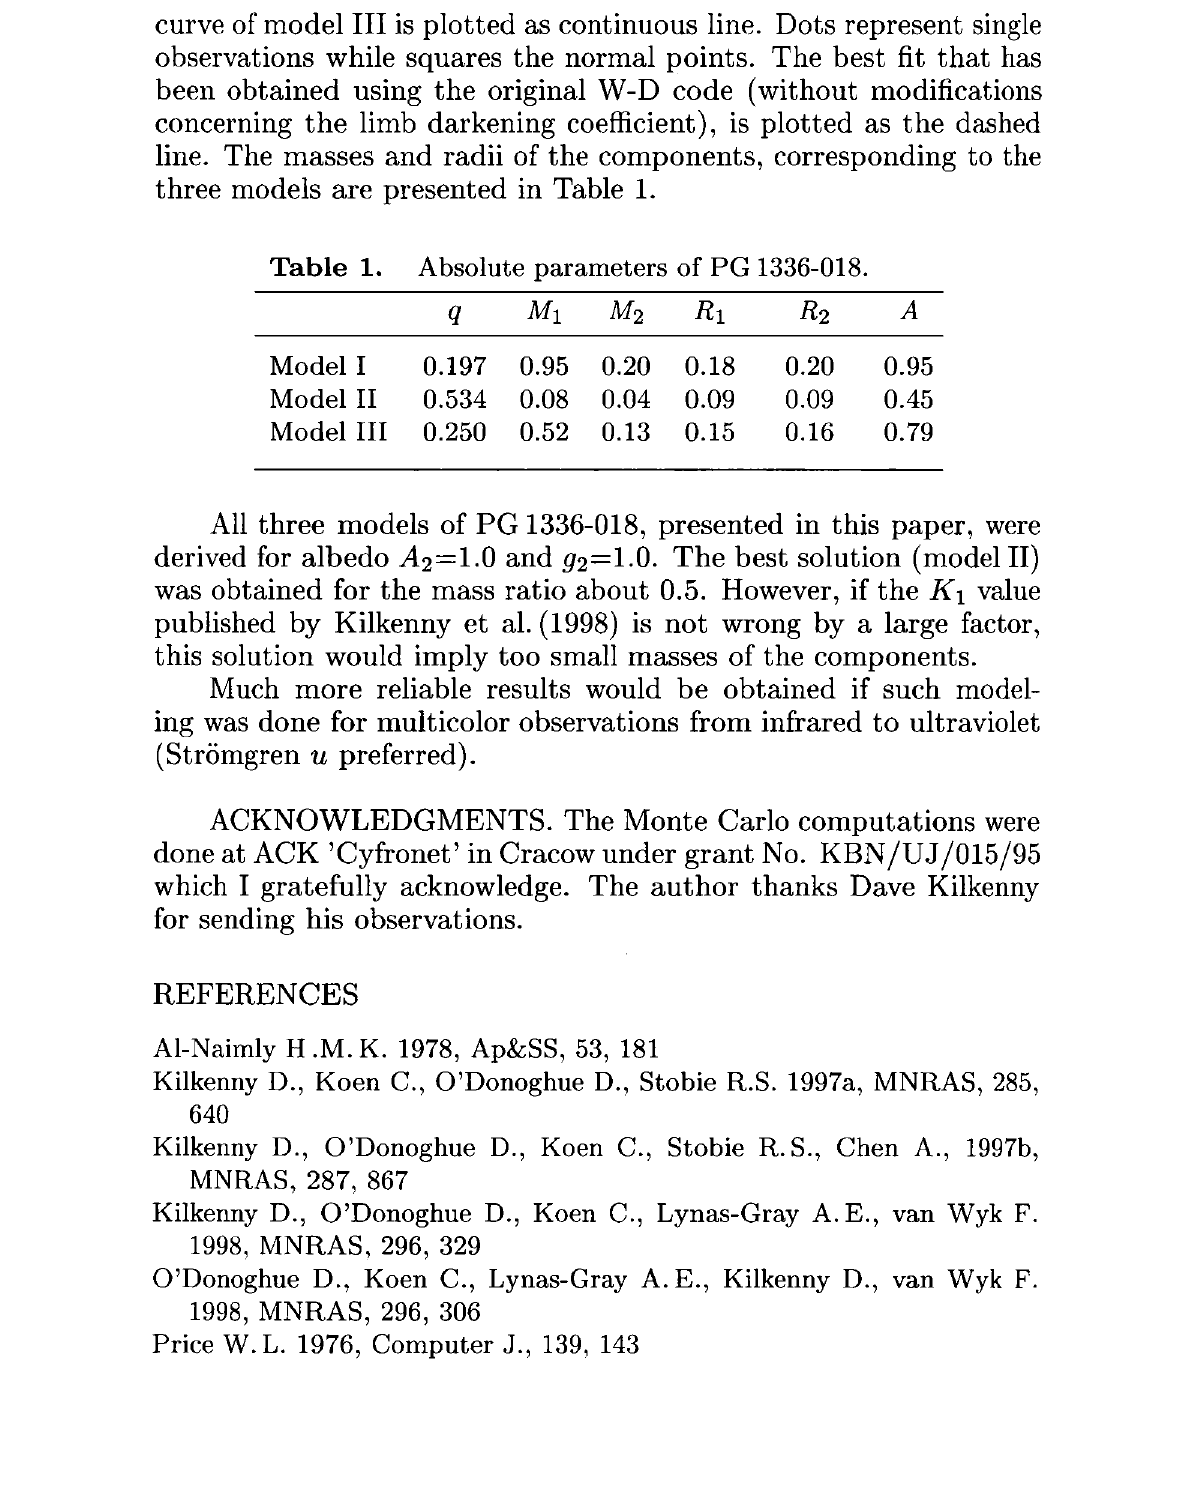
curve of model III is plotted as continuous line. Dots represent single observations while squares the normal points. The best fit that has been obtained using the original W-D code (without modifications concerning the limb darkening coefficient), is plotted as the dashed line. The masses and radii of the components, corresponding to the three models are presented in Table 1. Table 1. Absolute parameters of PG 1336-018.